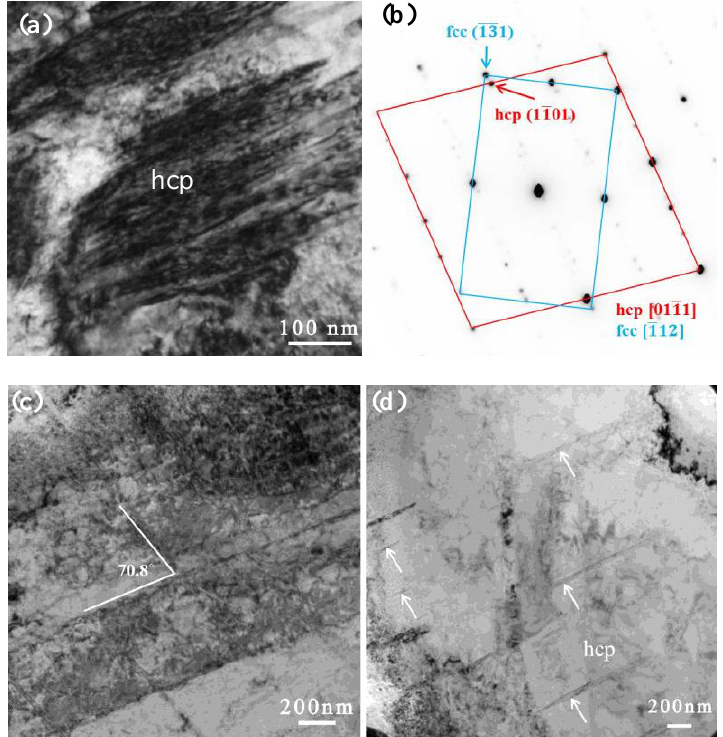
Figure 2. TEM images of the microstructure of the Fe-15Cr-15Ni alloy cryogenically treated at 77 K and heated to 773 K for a 2 × 10 17 ions cm −2 He + irradiation—showing ε martensite in the matrix. ( a ) ε-martensite (hcp phase) and ( b ) corresponding electron diffraction pattern, ( c ) and ( d ) nano-layers of ε-martensite.